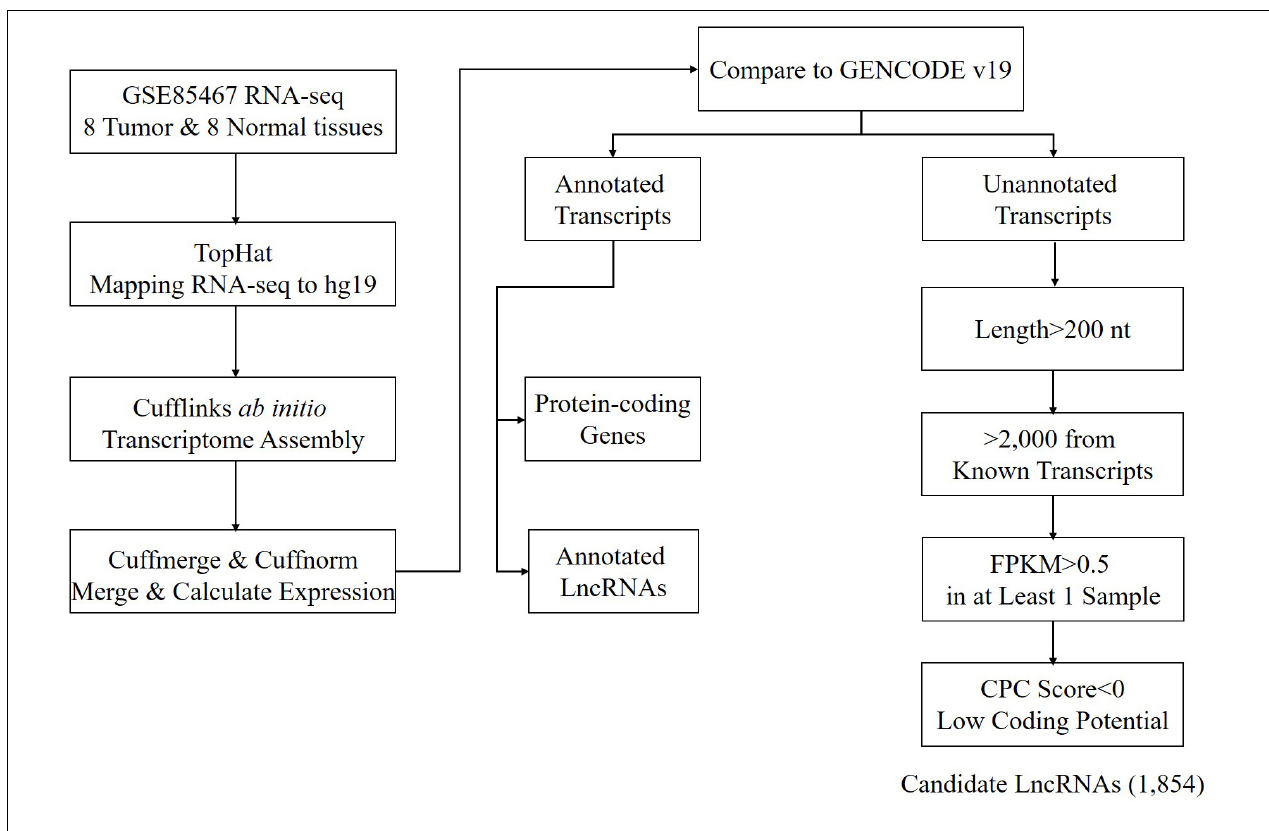
FIGURE 1 | Workflow of candidate lncRNA